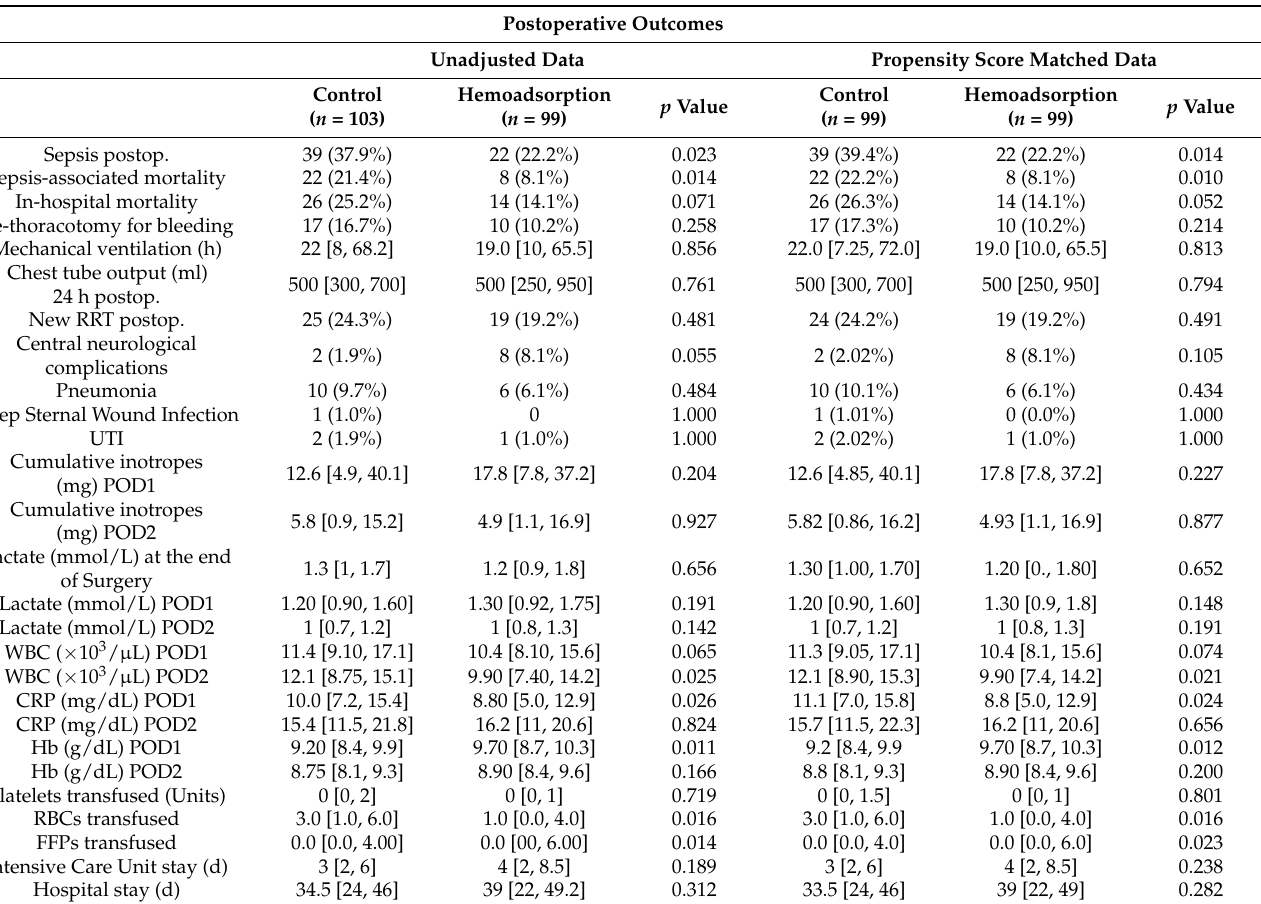
Table 3. Postoperative outcomes.